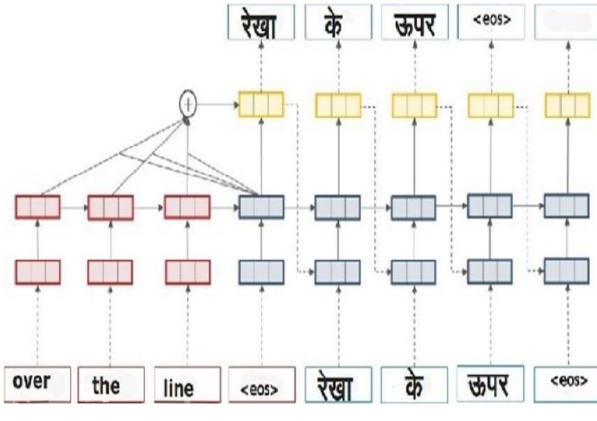
Fig. 2. System Design [3]